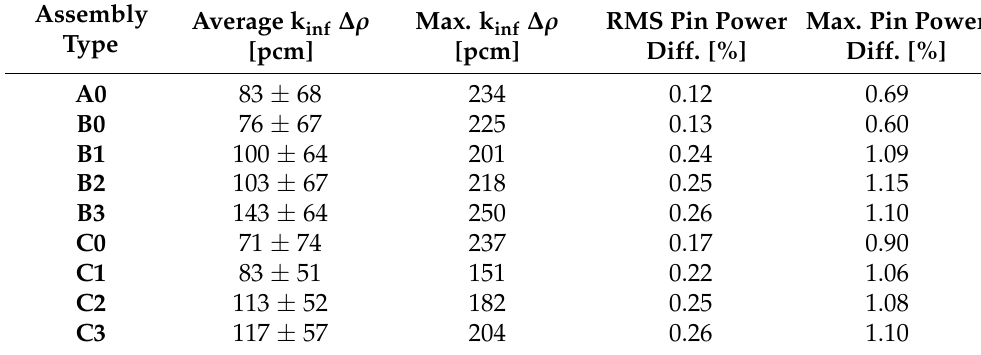
Table 3. Single 2-D assembly results by assembly type.